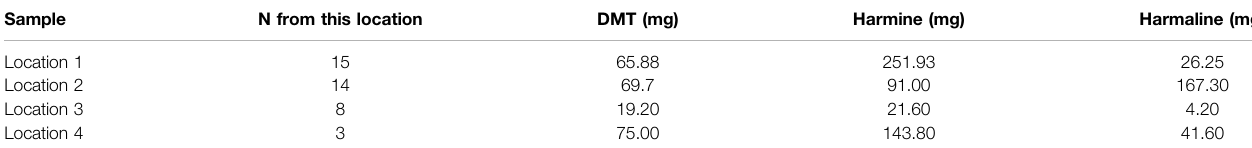
TABLE 1 | Estimated average total dose per site, based on alkaloid concentrations and reported amounts of the brew that participants have taken. Sample